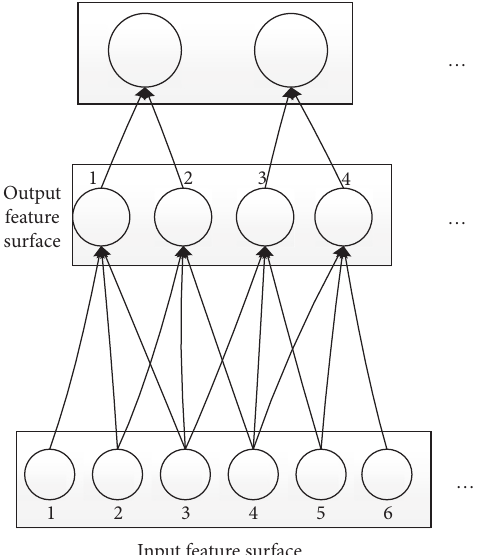
Figure 1: Schematic diagram of convolutional layer and pooling